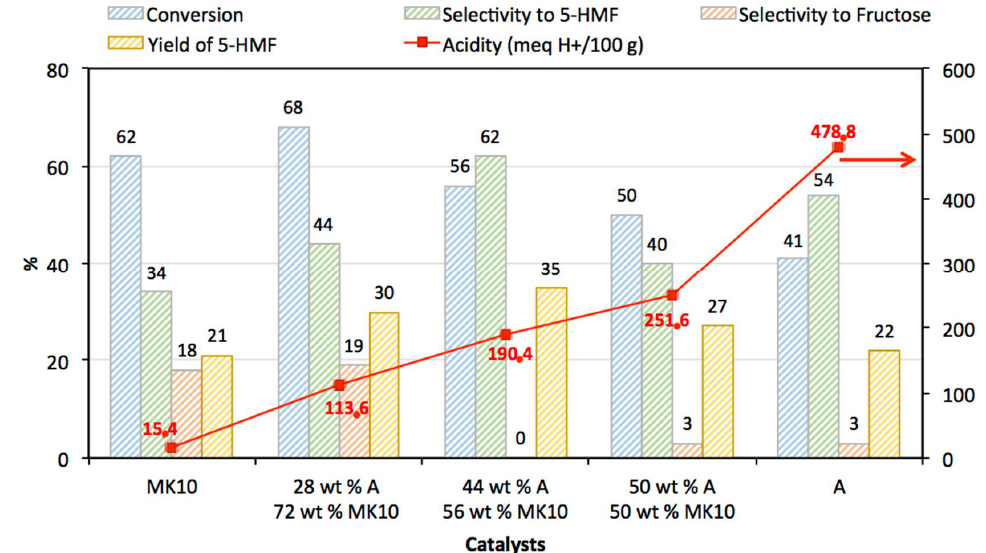
Figure 5. Catalytic activity of physical mixtures A-MK10 in different proportions compared to A and MK10 catalysts. Reaction conditions: 2.4 g of glucose, 0.6 g of catalyst mixture, catalyst/glucose wt ratio = 0.25, solvent volume ratio (THF:H 2 O) = 35:15, temperature = 140 °C and reaction time = 4 h.